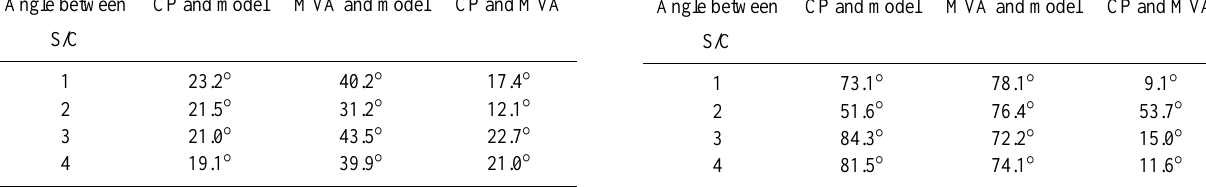
Table 1. First crossing: Comparison of the directions of the mag- netopause normal determined by Sibeck’s model, the CP, and the MVA methods, respectively Angle between CP and model MVA and model CP and MVA S/C